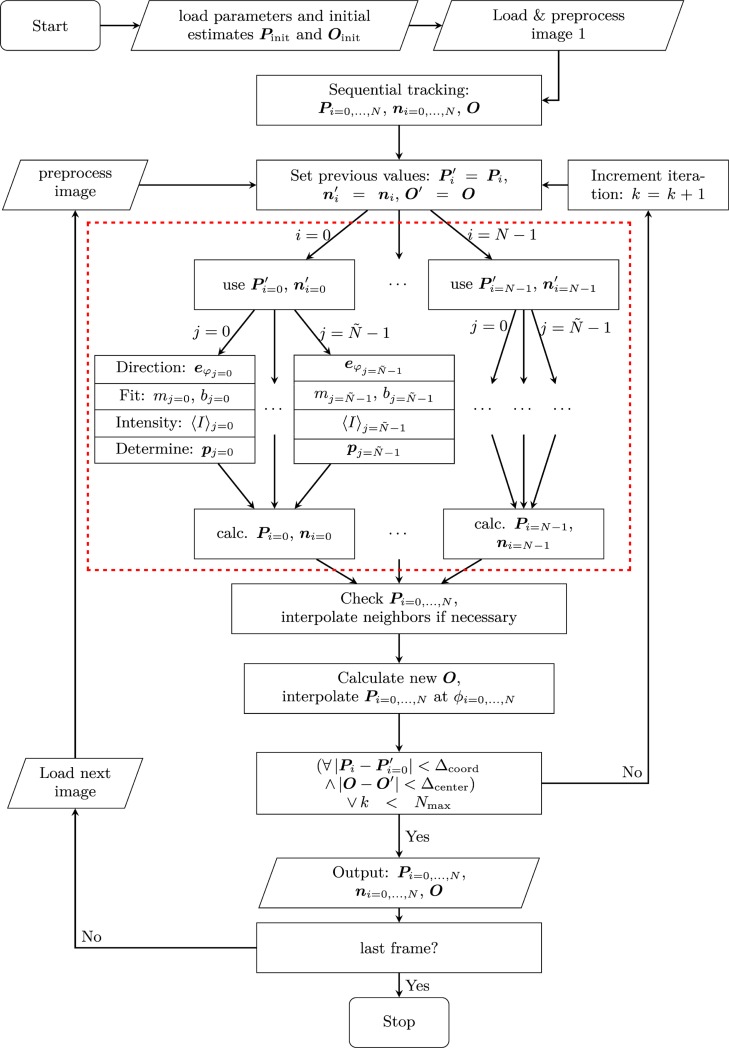
Flow-chart of the segmentation algorithm illustrating the steps that are taken in processing the movie.The section indicated by the red rectangle indicates the embarrassingly parallel part of the algorithm, which can easily be adapted for parallel processing on a GPU.